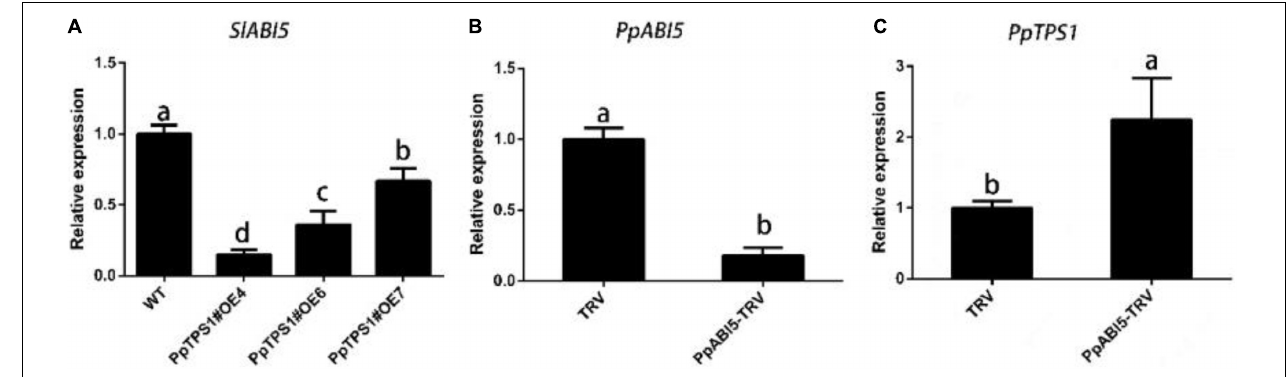
FIGURE 4 | Analysis of the antagonistic relationship between PpTPS1 and PpABI5 . (A) Analysis of the expression of the PpABI5 homologous gene SlABI5 in three transgenic tomato lines, OE4, OE6, and OE7. (B) The expression level of PpABI5 after 4 days of transient silencing of PpABI5 in peach fruit by the VIGS system using TRV as a vector. (C) Analysis of PpTPS1 expression after transient silencing of PpABI5 . Biological triplicates were performed for each sample. Different letters represent significant differences according to ANOVA and Duncan’s test ( P <